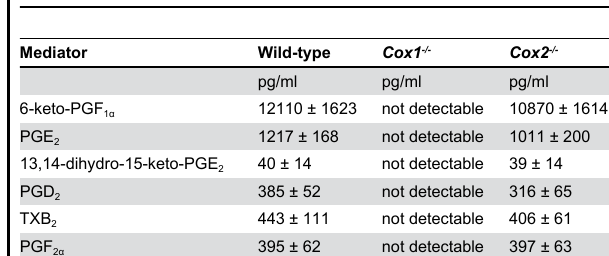
Table 1. Prostanoid release by isolated aortic rings, measured by